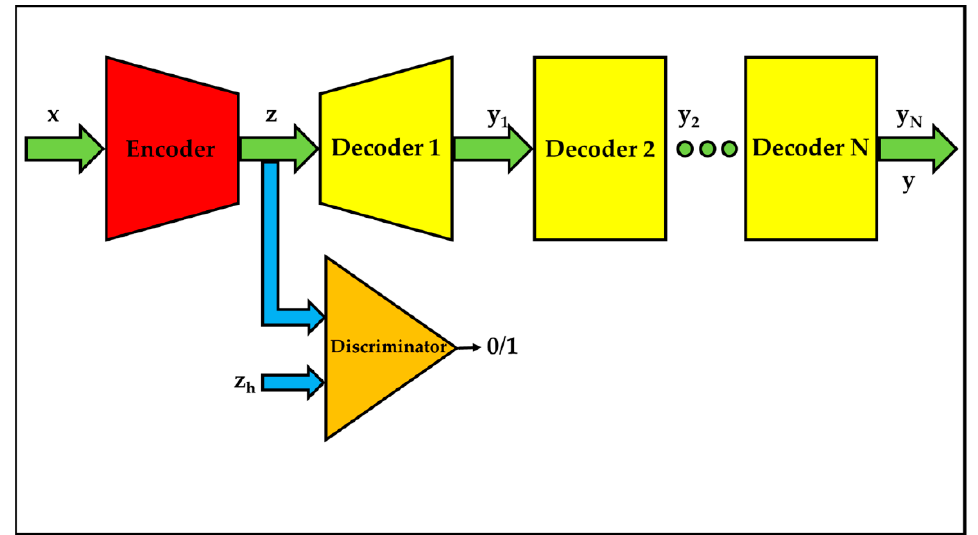
Figure 8. The architecture of cascade decoders-based adversarial auto-encoders.